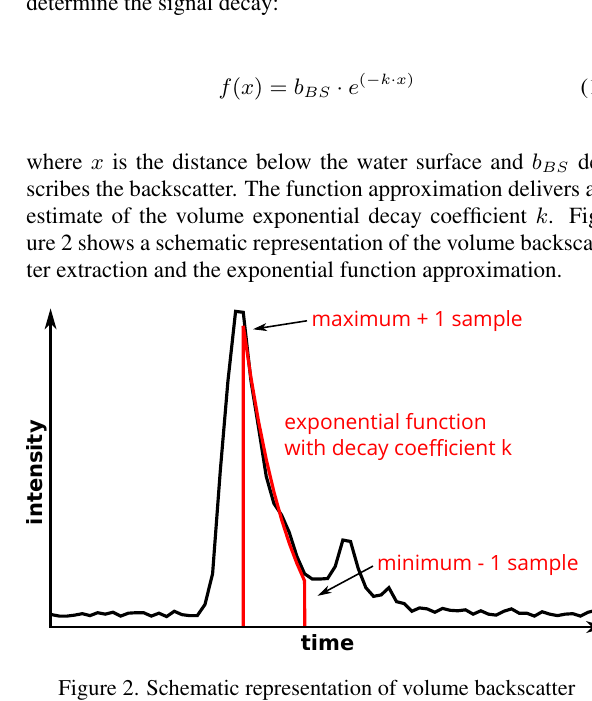
Figure 2. Schematic representation of volume backscatter extraction and exponential function